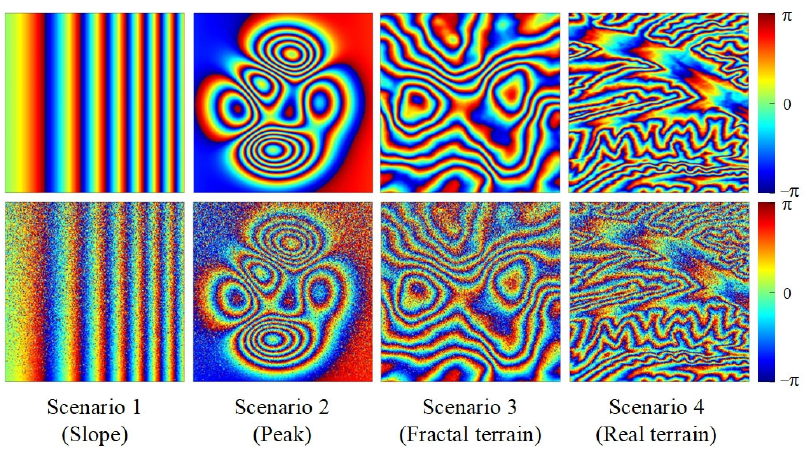
Figure 2. Four simulated interferograms with different distribution characteristics ranging from no noise (top row) to fading noise (bottom row).